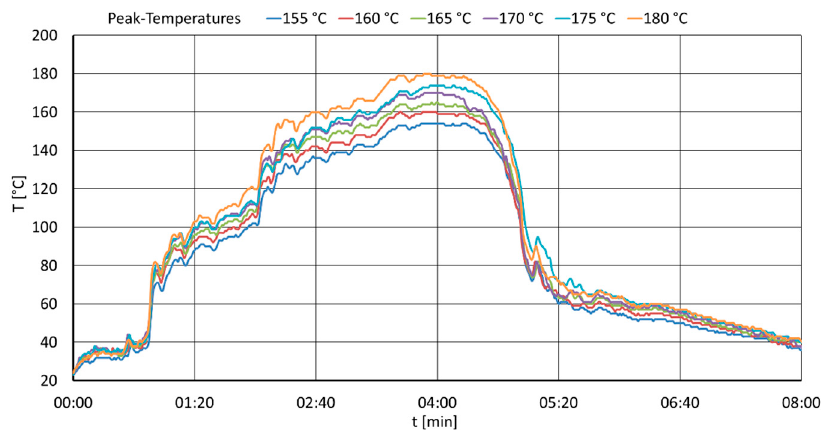
Figure 2. Measured temperature profiles for different peak temperatures.